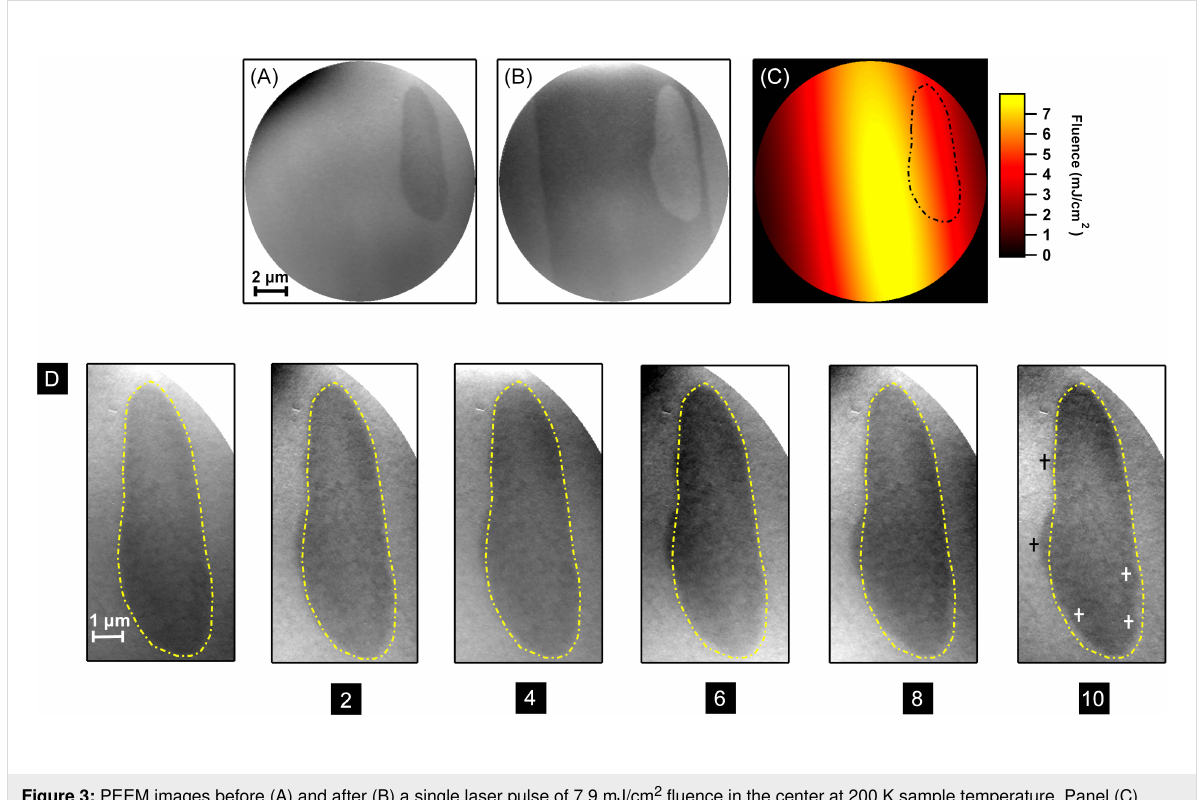
Figure 3: PEEM images before (A) and after (B) a single laser pulse of 7.9 mJ/cm 2 fluence in the center at 200 K sample temperature. Panel (C) shows the laser fluence as a two-dimensional Gaussian profile. Row D shows the configuration of the single domain after different numbers of laser pulses as given at the bottom of each image. The yellow dashed line indicates the initial position of a magnetic